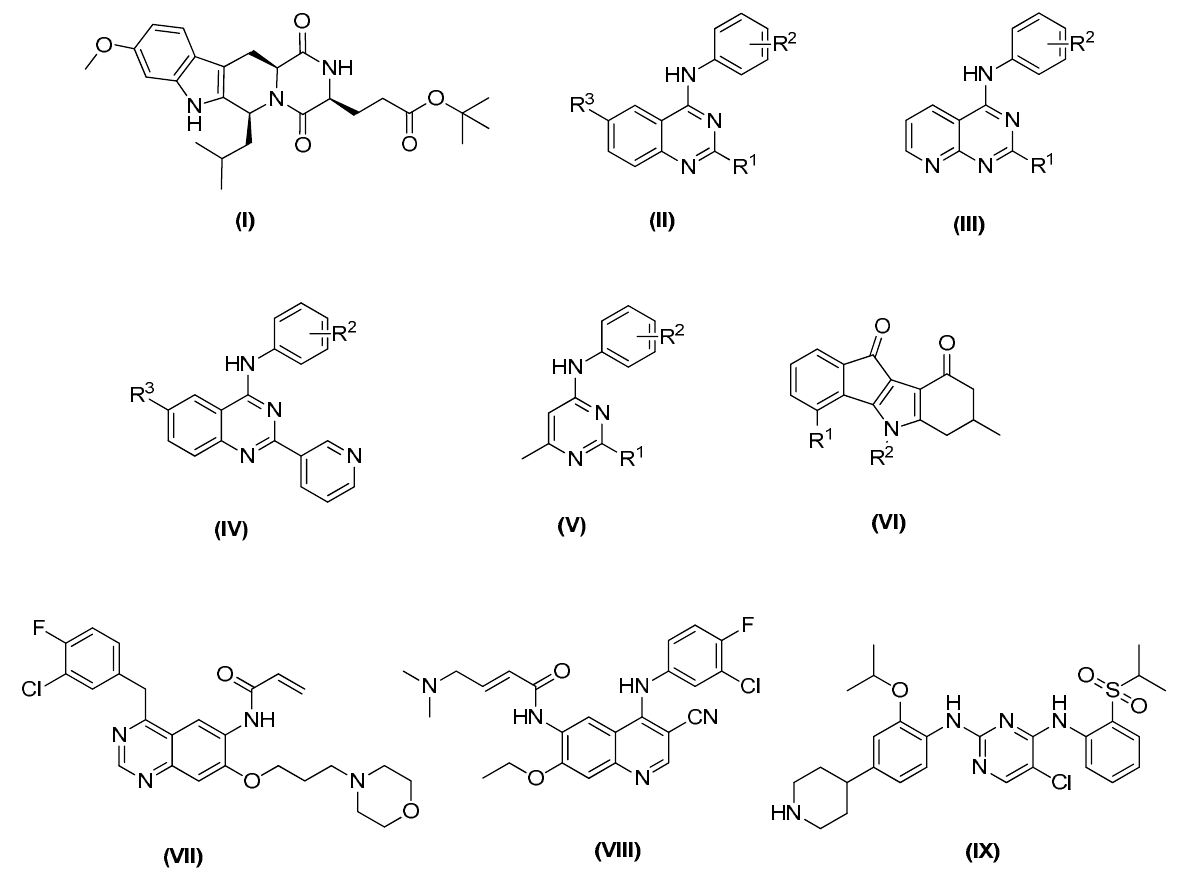
Figure 1. Recent ABCG2 inhibitors: Ko143 ( I ); small molecules based on 1,4,6-substituted quinazoline scaffold ( II ), 2,4-disubstituted pyridopyrimidine scaffold ( III ), 4-anilino-2-pyridyl quinazoline scaffold ( IV ) and 4-methyl-pyrimidine scaffold ( V ); general structure of indeno [1,2-b]indole-9,10-dione ( VI ); new multitarget tyrosine kinase inhibitors (TKIs) reversers of ABCB1-, ABCC1-, and ABCG2-mediated MDR, canertinib ( VII ), pelitinib ( VIII ) and ceritinib ( IX ).